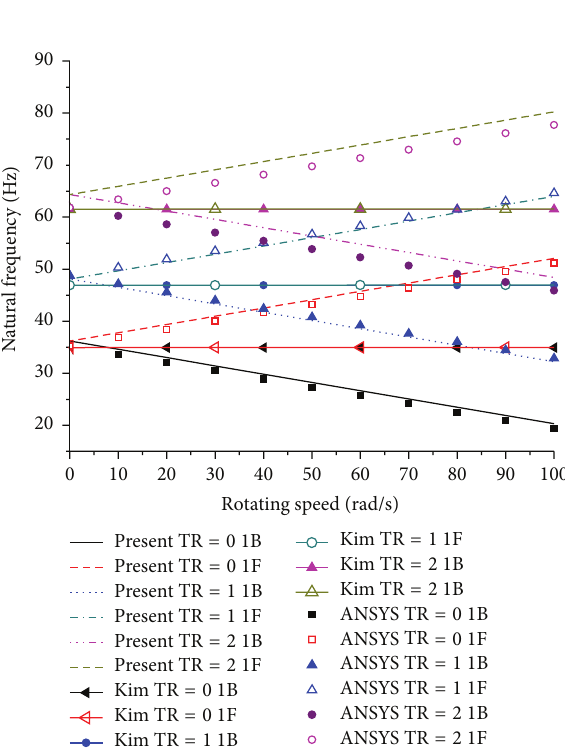
Figure 8: Changes comparison with rotating speed ( 𝜃 = 60 ∘